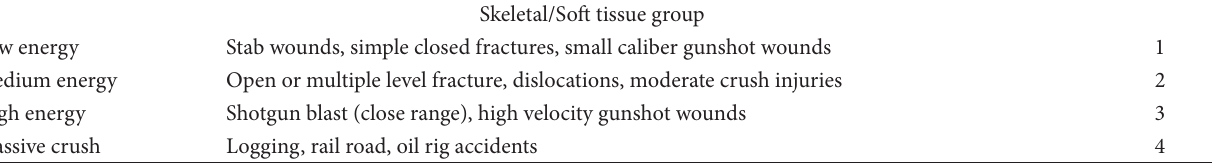
Table 1: Mangled extremity severity score. Skeletal/Soft tissue